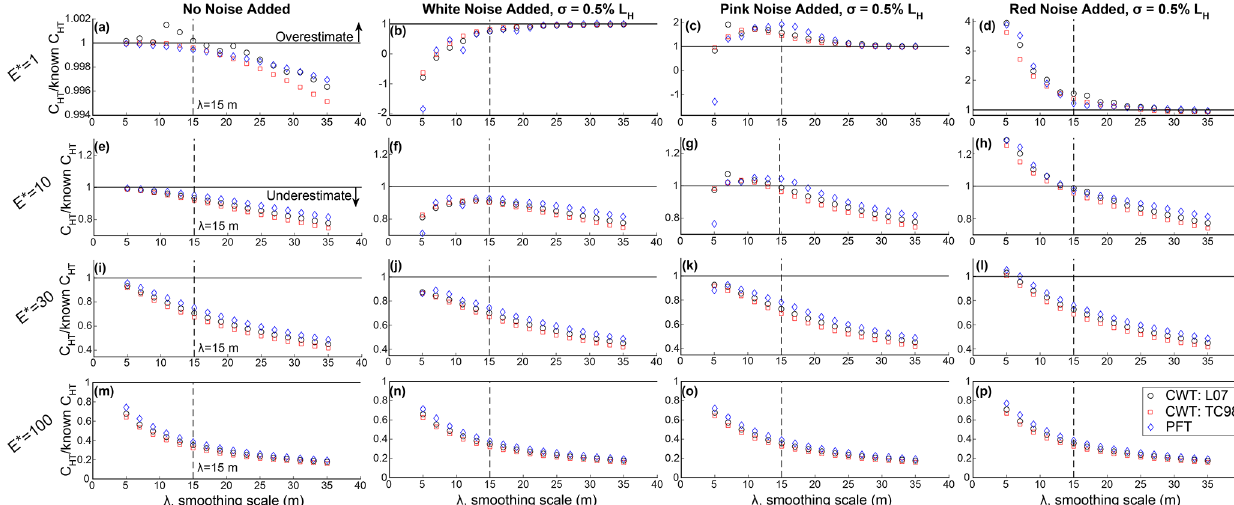
Figure 10. Ratio of C HT of synthetic hillslopes where E ∗ = 1, 10, 30, and 100 measured at various smoothing scales, λ , with no noise added (first column), σ = 0 . 5% L H white noise (second column), pink noise (third column), and red (Brownian) noise (fourth column). Ratio of C HT is quantified as the quotient of the C HT-W or C HT-P and the model-specified C HT . Black horizontal line in each panel corresponds with where the measured C HT equals the actual synthetic C HT (i.e., ratio = 1). Points that plot above the line correspond with locations where C HT is overestimated (sharper hilltops than expected); points that plot below are underestimations (broader hilltops that expected). See text for details but note the systematic underestimation of C HT as E ∗ increases, even for the surface with no added noise. Dashed vertical line indicates λ = 15m. Note that y axis differs between E ∗ = 1 plots. L07: Lashermes et al. (2007); TC98: Torrence and Compo